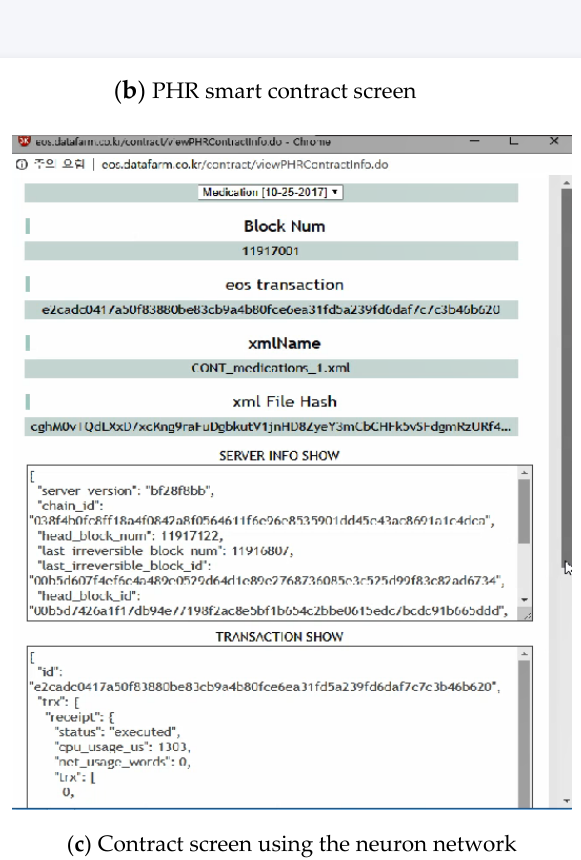
Figure 18. Blockchain PHR smart contract screen using the neural network.